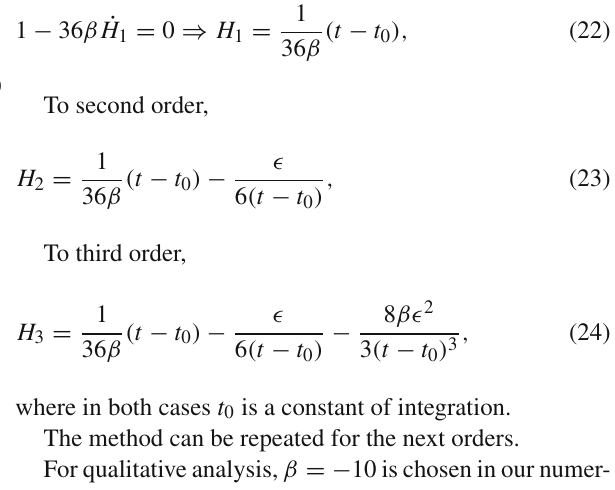
where the parameter (cid:8) as before is dimensionless and set to unity in the end with H n (cid:8)= 0 and the equation is dimension- less in the proper time t. The conditions used are | β